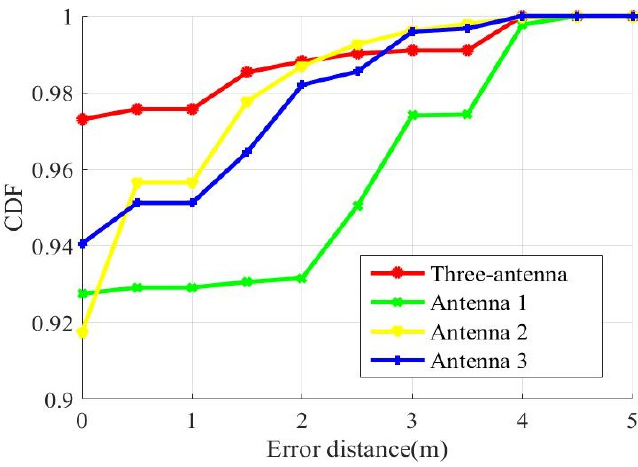
Figure 11. Localization precision with different antenna.